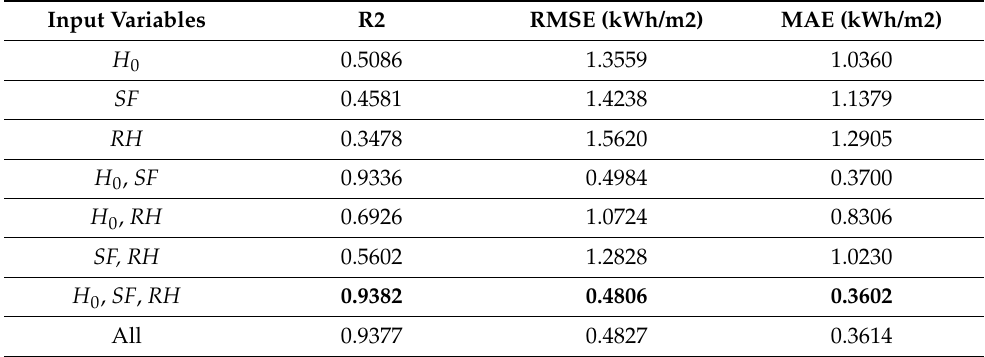
Table 5. Statistical results for eight LightGBM models during the testing phase (bold represents best